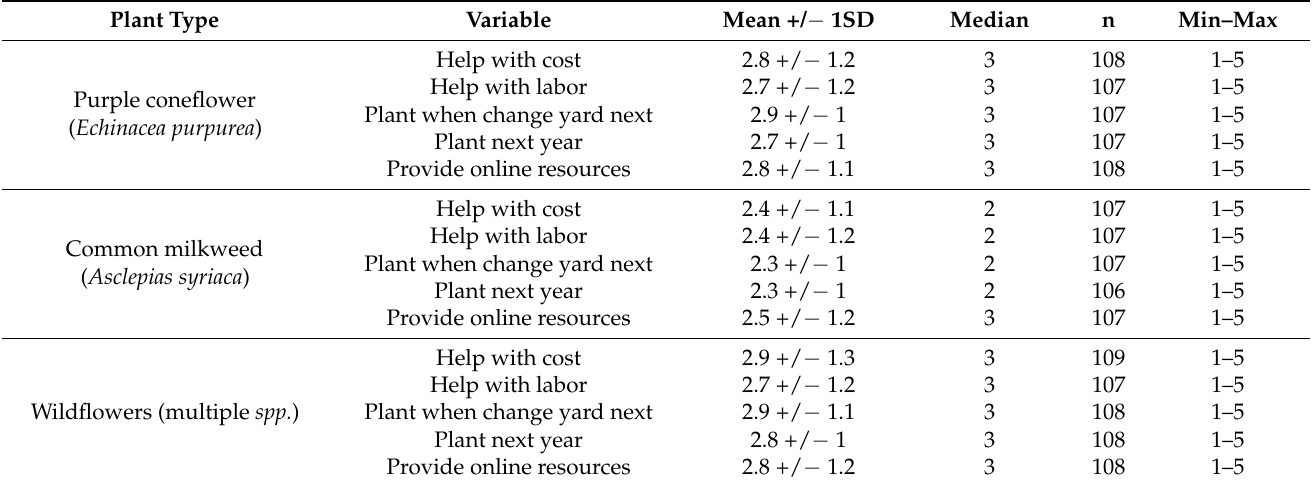
Table 1. Summary statistics for reported intent to plant the native plants shown in the survey when various types of assistance or options for different timing of plantings are given. Mean +/ − 1 standard deviation (SD) and median for stated willingness (i.e., reported intent) to plant purple coneflower, common milkweed and wildflowers if assistance is provided with costs, labor, or provision of online resources; mean +/ − 1 standard deviation (SD) and median for stated willingness to add the particular plant within the next year, or the next time landscaping changes are made to the yard. Higher values indicate that the respondent is more willing to plant the plants shown in the survey. The scale varies from 1 to 5, with 5 standing for “Strongly agree,” and 1 “Strongly disagree” so that a value of three is neutral (“Neither agree nor disagree”). All means are below three, but especially for common milkweed. The number of respondents who answered each question is provided in the column labelled